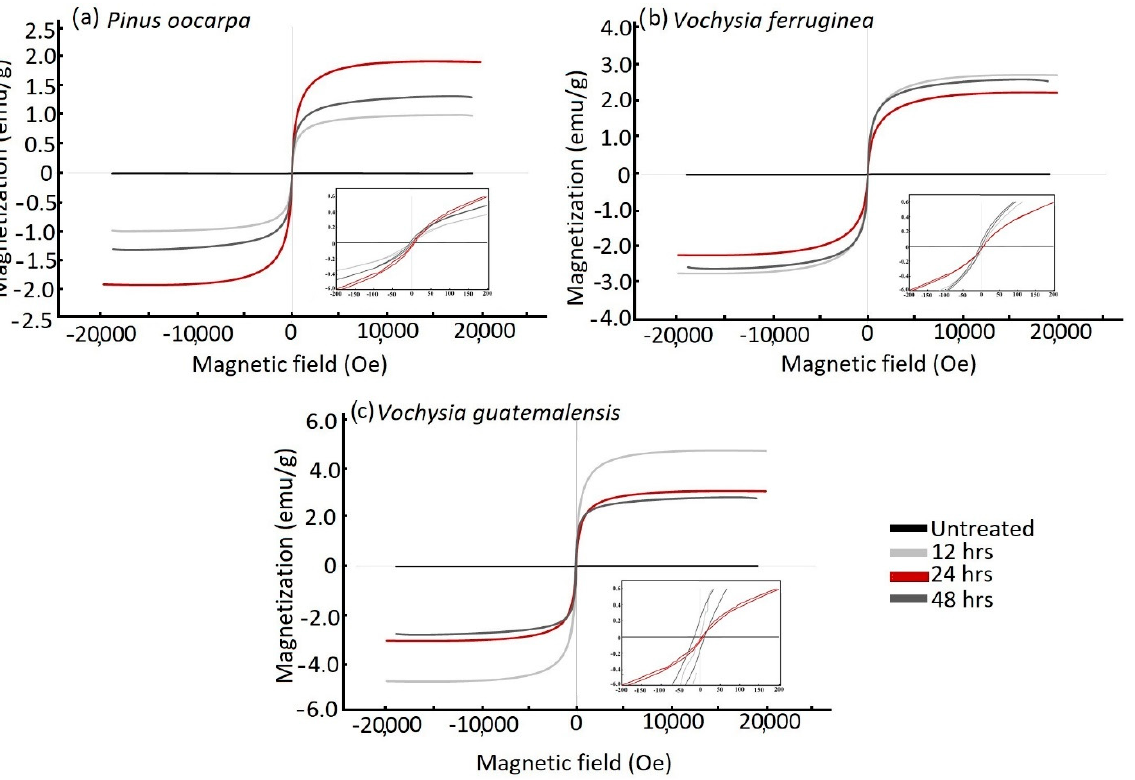
Figure 5. Magnetic hysteresis curves of untreated wood and magnetic wood with three different immersion times in ammonia in three tropical wood species from fast-growth plantations in Costa Rica: ( a ) Pinus oocarpa , ( b ) Vochysia ferruginea and ( c ) Vochysia guatemalensis .